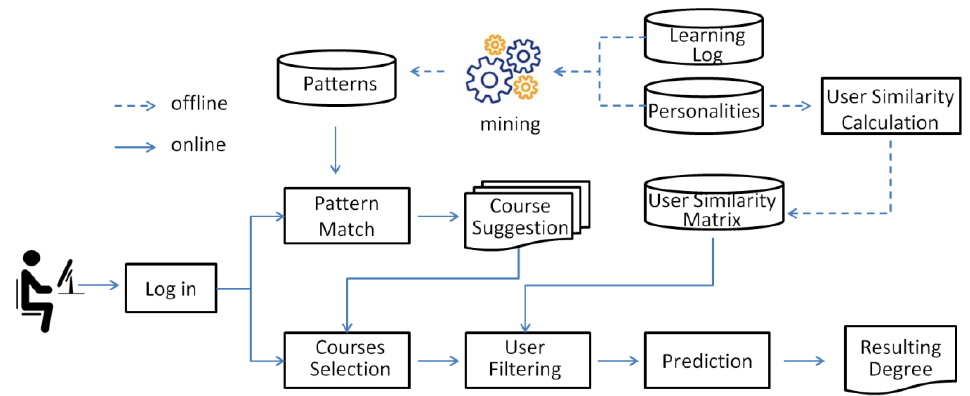
Figure 2. Framework of the proposed method.